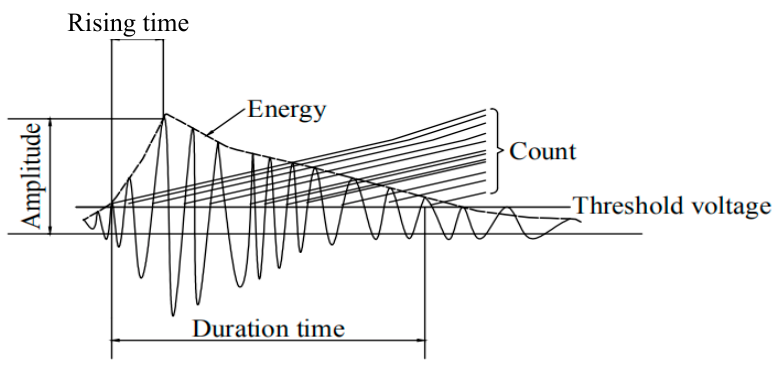
Figure 1. Principle of acoustic emission.